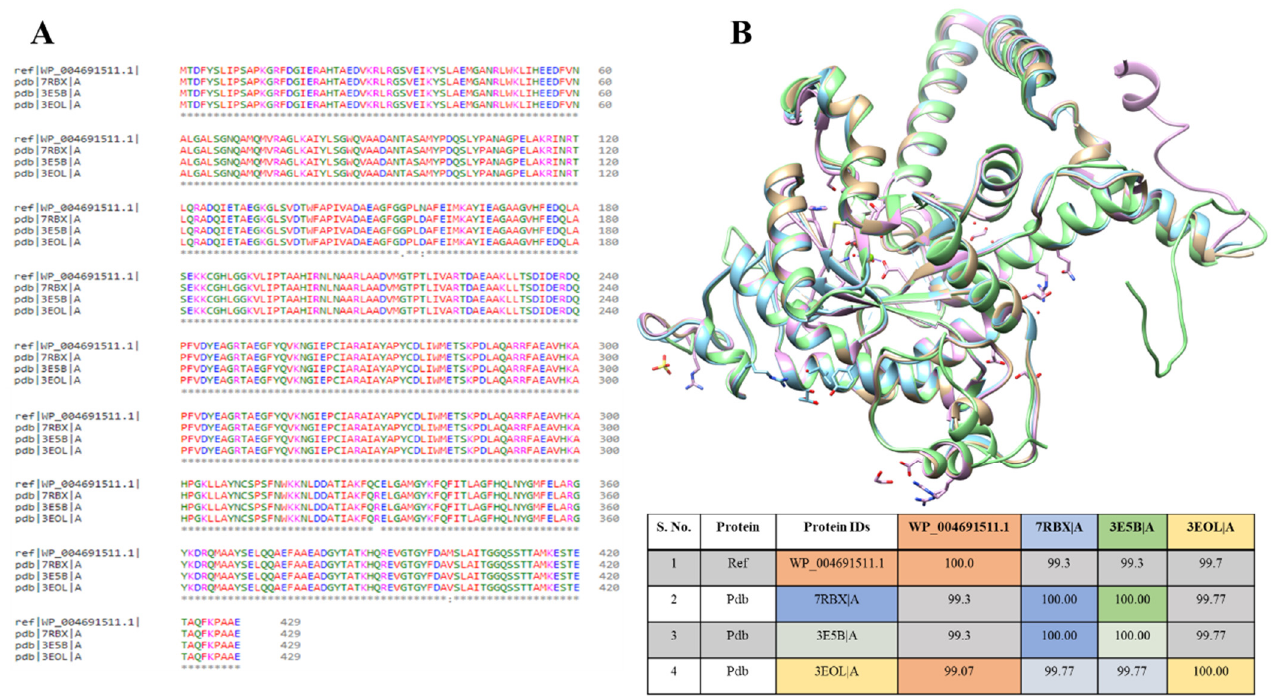
Figure 4. Multiple sequences alignment of ICL. ( A ) MSA of ICL from B. suis aligned with ICL protein from B. abortus 2308 (PDB ID: 7RBX), B. melitensis (PDB ID: 3E5B), and B. melitensis (P43212) (PDB ID: 3EOL) showing ~99.3% sequence similarity. ( B ) The superimposed structure of ICL proteins from B. suis (green color), B. abortus (blue), B. melitensis (tan), and B. melitensis P43212 (pink) showing the RMSD of ~2 Å among each other.